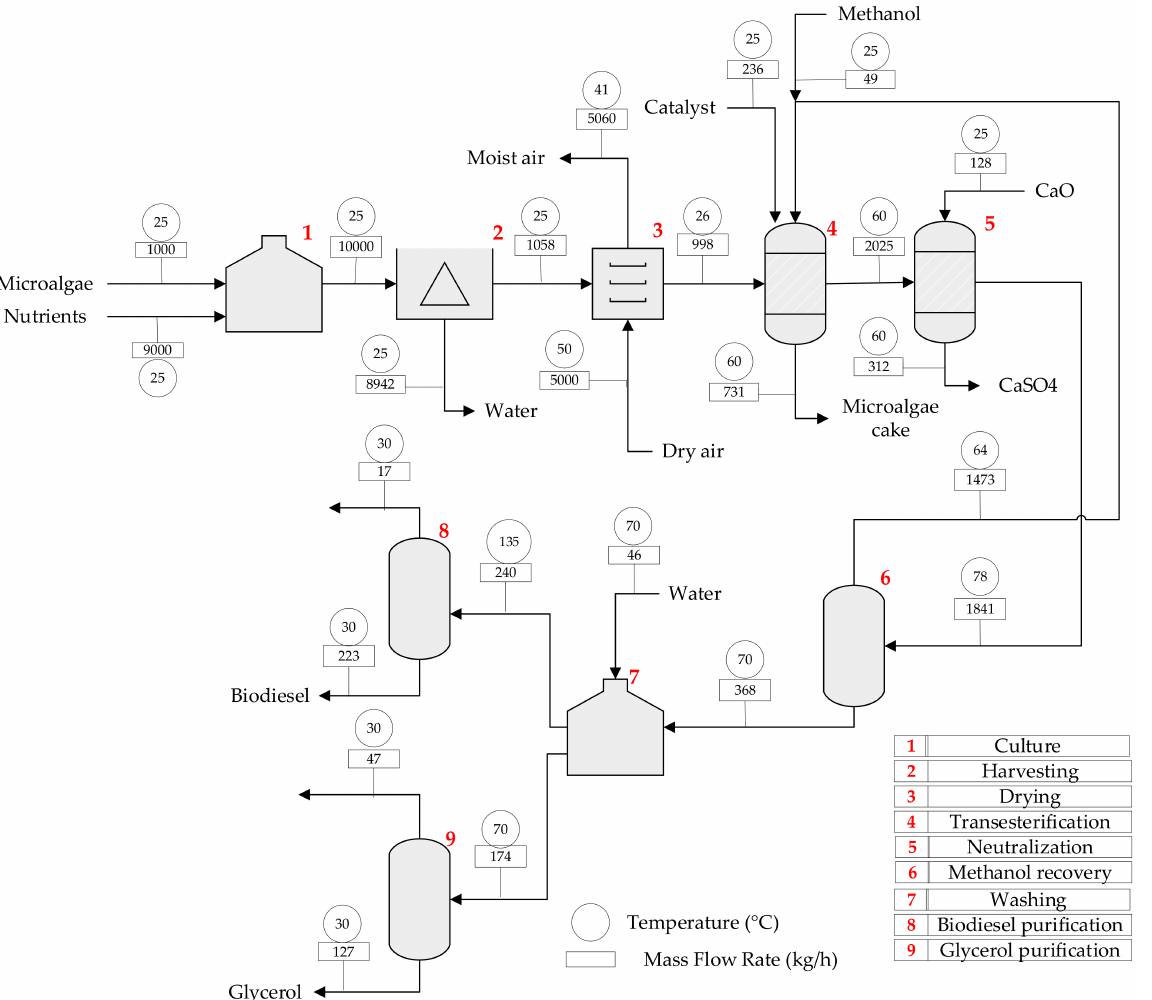
Figure 3. Process diagram for biodiesel production from microalgae via in situ